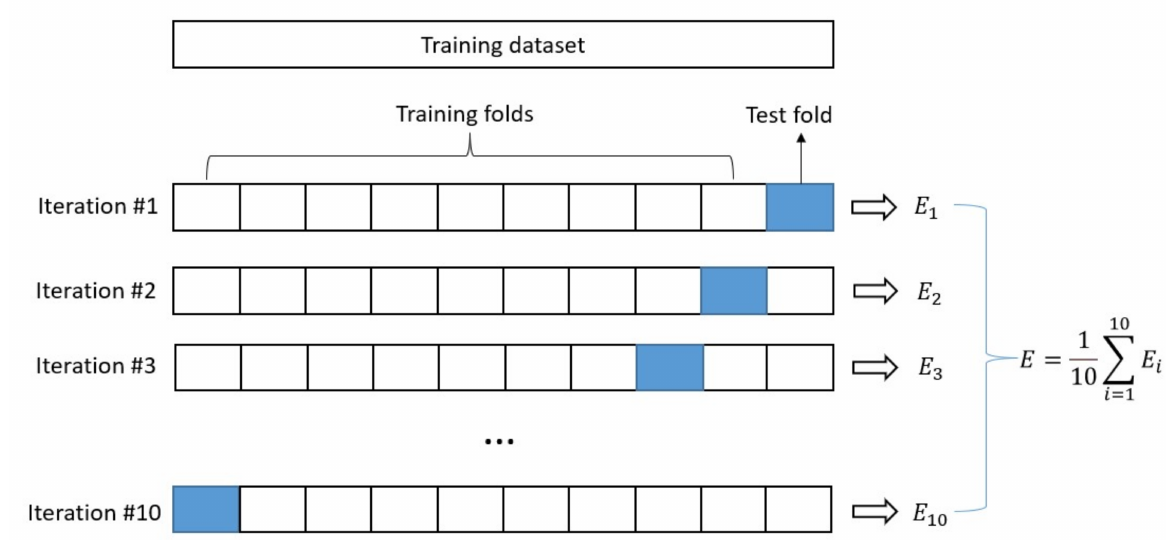
Figure 2. Schematic diagram of ten-fold